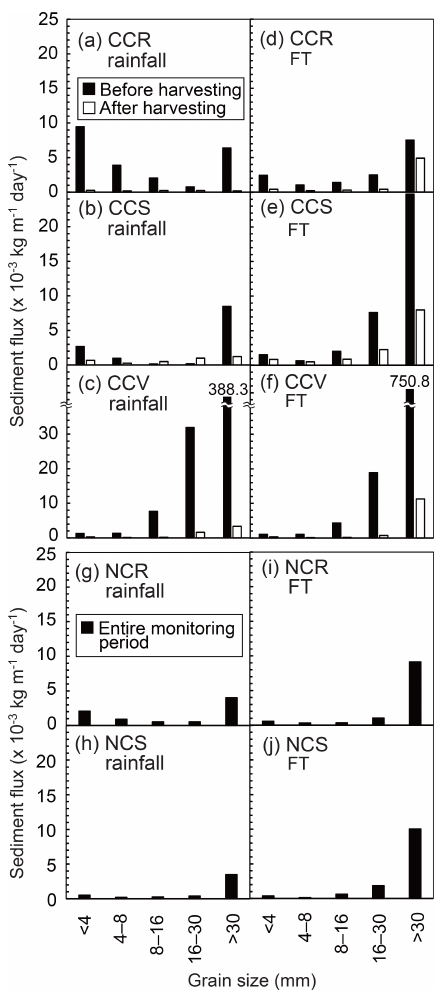
Figure 12. Average sediment flux of each grain-size class in a har- vested area (site CC). (a) Sediment flux at plot CCR in rainfall peri- ods. (b) Sediment flux at plot CCS in rainfall periods. (c) Sediment flux at plot CCV in rainfall periods. (d) Sediment flux at plot CCR in freeze–thaw periods. (e) Sediment flux at plot CCS in freeze– thaw periods. (f) Sediment flux at plot CCV in freeze–thaw peri- ods. (g) Sediment flux at plot NCR in rainfall periods. (h) Sediment flux at plot NCS in rainfall periods. (i) Sediment flux at plot NCR in freeze–thaw periods. (j) Sediment flux at plot NCS in freeze–thaw periods.